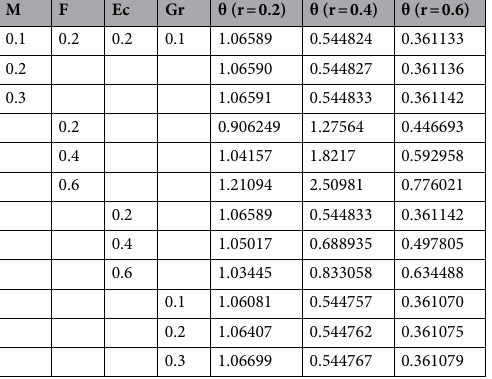
Table 4. Results for temperature profile against nondimensional parameters.